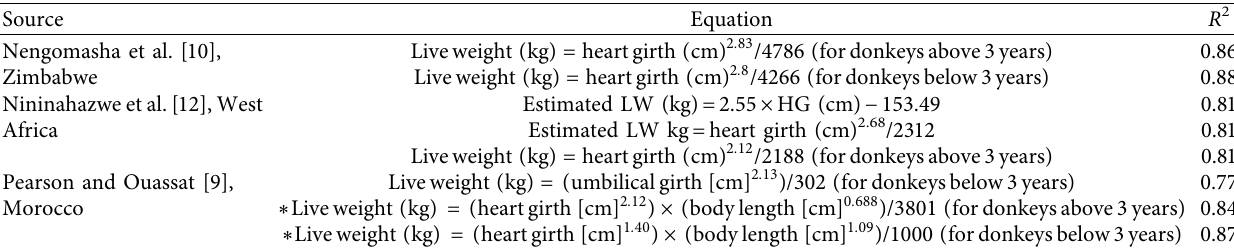
Table 1: A comparison of different equations for estimating the live weight of working donkeys and their respective regression coefficients ( R 2 ).